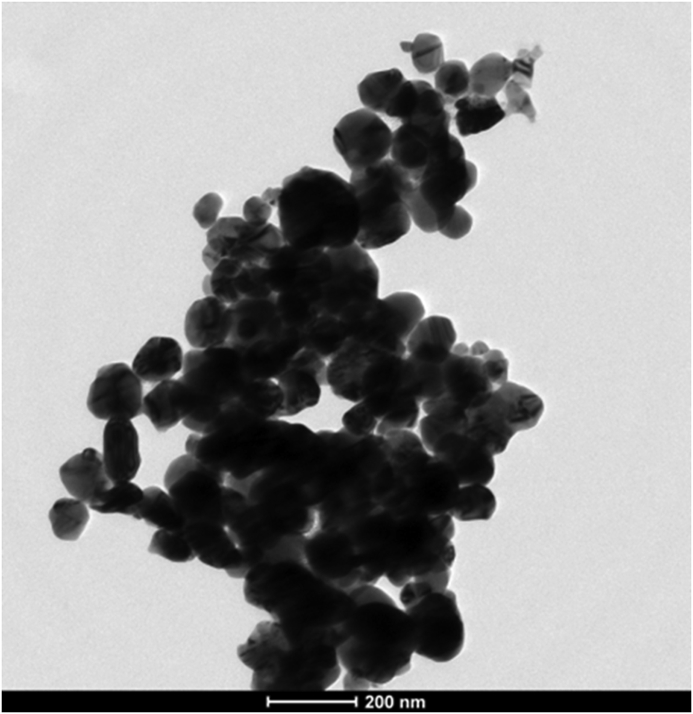
Transmission electron micrograph showing the spherical shape of the synthesized Cu/Cu2O NPs.